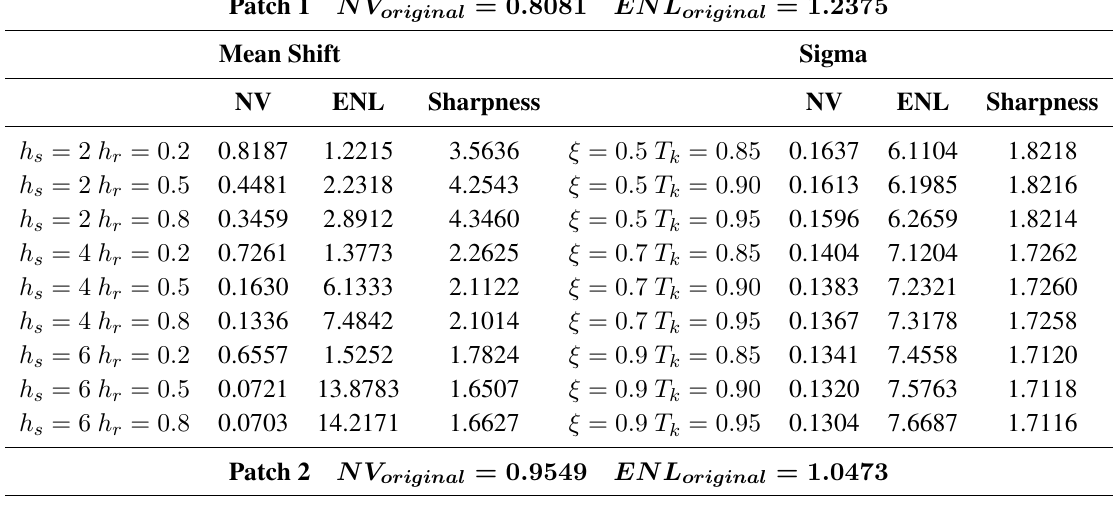
Table 3. Quality parameters estimation for mean shift and sigma filtering. NV, noise variance; ENL, equivalent number of